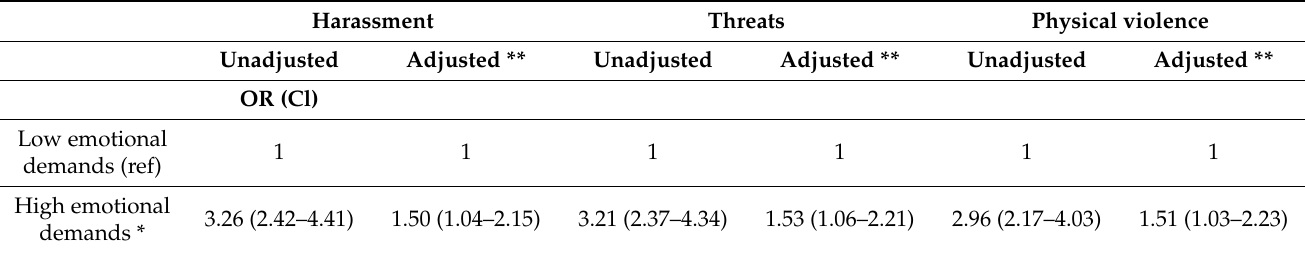
Table 3. Associations between emotional demands at work and harassment, threats and violence.